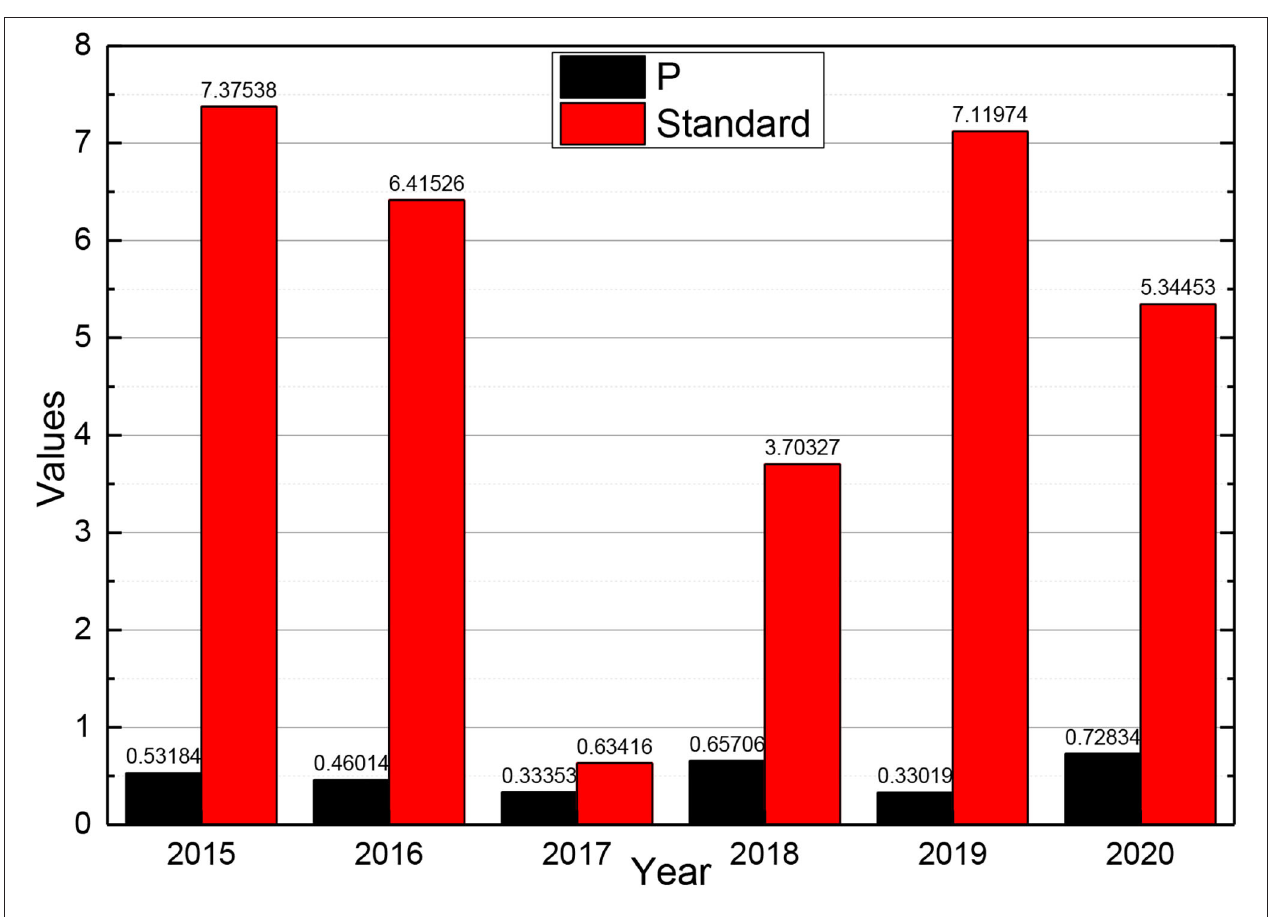
FIGURE 6 | Change in P -value from 2015 to